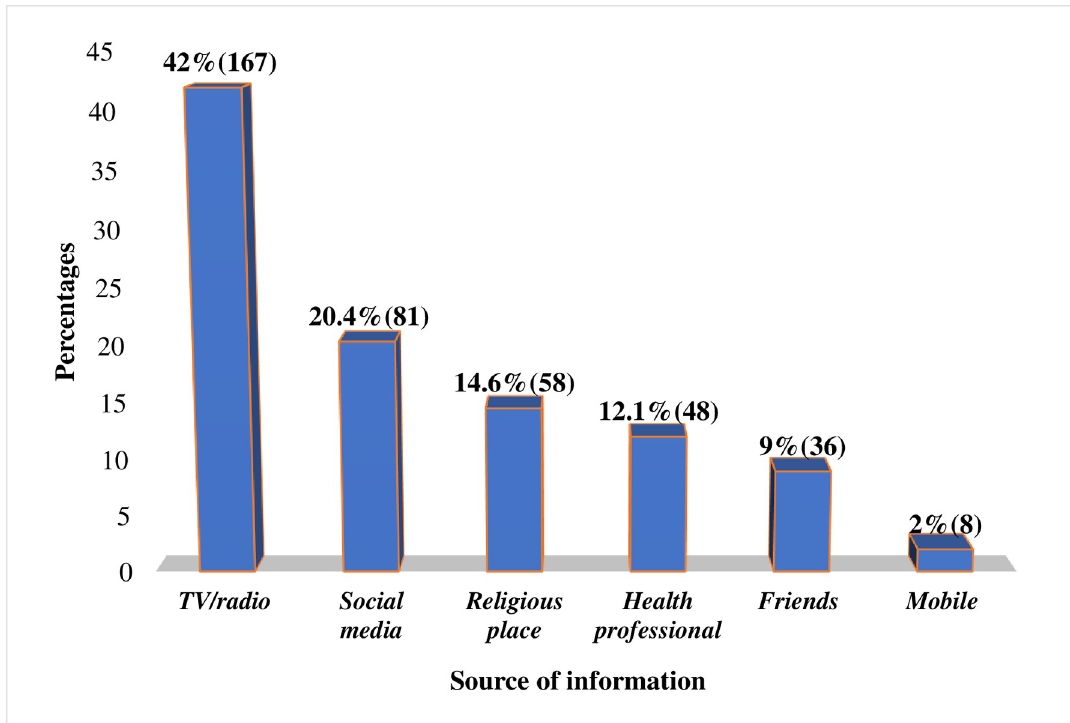
Fig 1. Source of information about COVID-19 among the outpatient service visitors at Debre Markos compressive specialized hospital, Amhara regional state, Ethiopia, 2020.